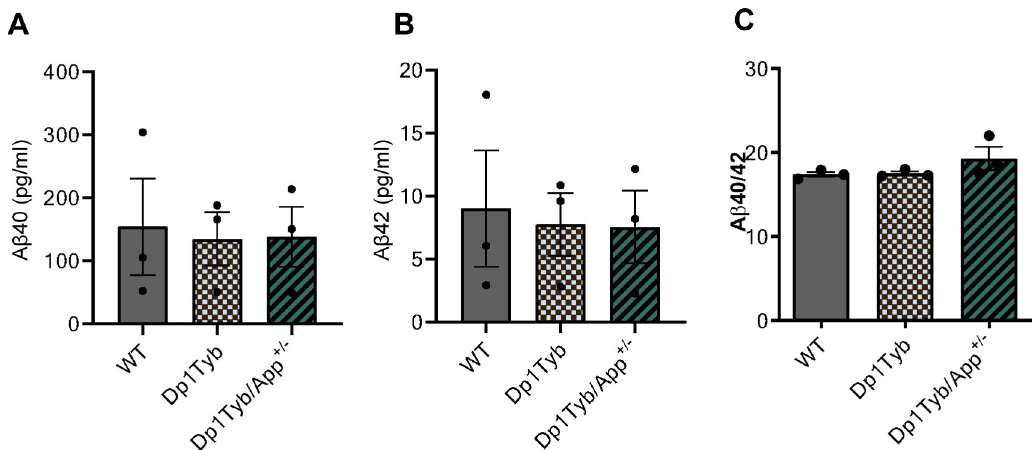
Fig 3. Trisomy of Hsa21-homologous genes, including or excluding App , does not affect A β 40/A β 42ratio. In WT, Dp1Tyb and Dp1Tyb/ App +/- MEFs overexpressing APP- β -CTF led to no difference in A) A β 40 abundance (Dp1Tyb = 134.9 ± 42.5; Dp1Tyb/ App +/- = 138.2 ± 47.75; WT = 154.1 ± 76.59. One-way ANOVA, p = 0.97, N = 3); B) A β 42 abundance (Dp1Tyb = 7.78 ± 2.5; Dp1Tyb/ App +/- = 7.56 ± 2.88; WT = 9.02 ± 4.61 in pg/ml. One-way ANOVA, p = 0.95, N = 3) or C) A β 40/ A β 42 ratio (Dp1Tyb = 17.51 ± 0.24; Dp1Tyb/ App +/- = 19.29 ± 1.37; WT = 17.38 ± 0.31. One-way ANOVA, p = 0.26, N = 3). Each dot corresponds to a biological repeat using an independent MEF lines. Error bars = SEM.